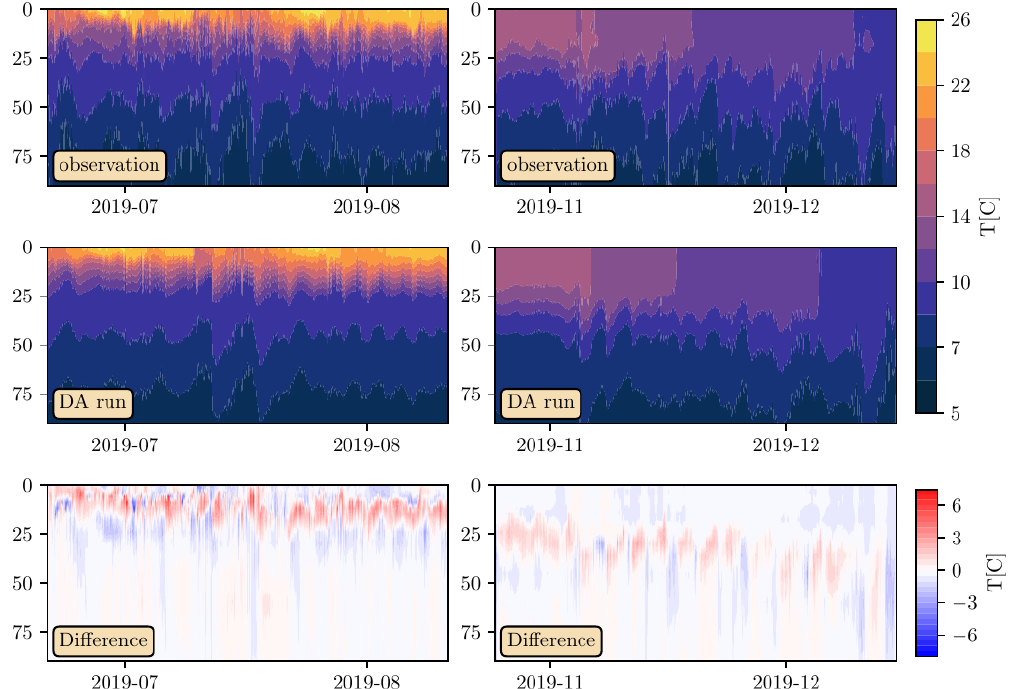
Figure 9. Vertical temperature profiles from the LéXPLORE sensors for the summer months (left) and late autumn (right). The top row shows the dataset, and the middle row shows the assimilated predictions. The bottom row shows the difference between the plots, with positive values indicating model overprediction.